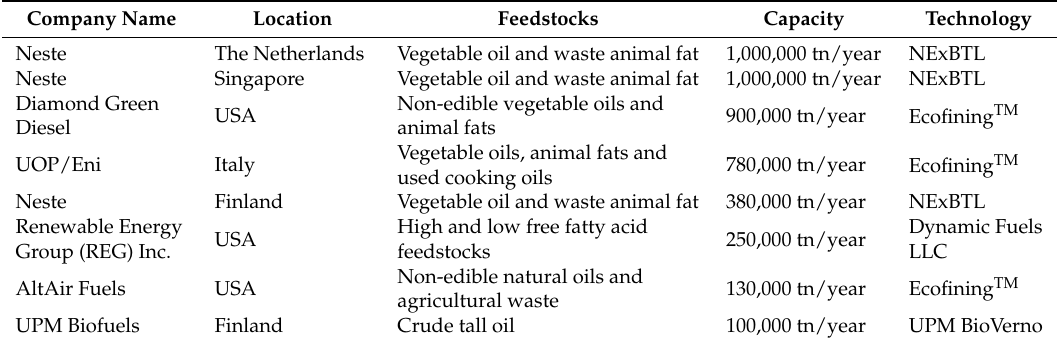
Table 4. List of the main green diesel producers currently in operation. Data from [62].